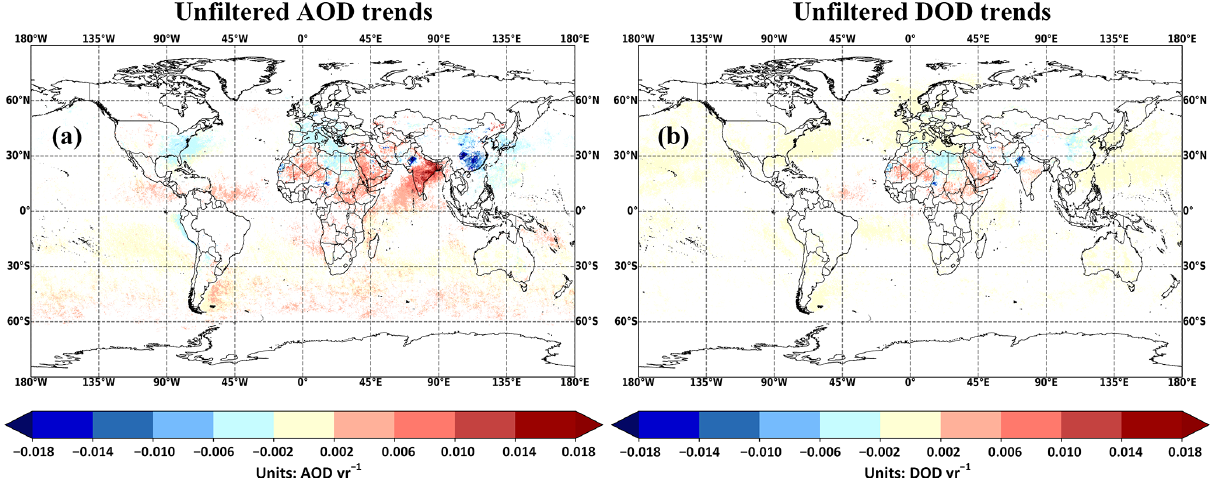
Figure 5. Global maps of unfiltered temporal trends (statistically significant at 95% confidence level) at 0 . 1 ◦ × 0 . 1 ◦ spatial resolution calculated from the deseasonalized geometric (a) AOD and (b) DOD monthly values during 2003–2017.